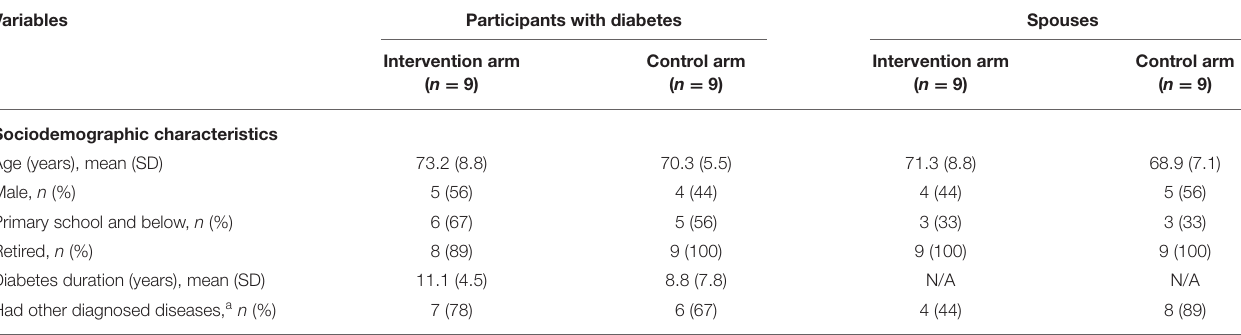
TABLE 1 | Couples’ sociodemographic characteristics of the 3-month pilot study (couple pairs N = 18).